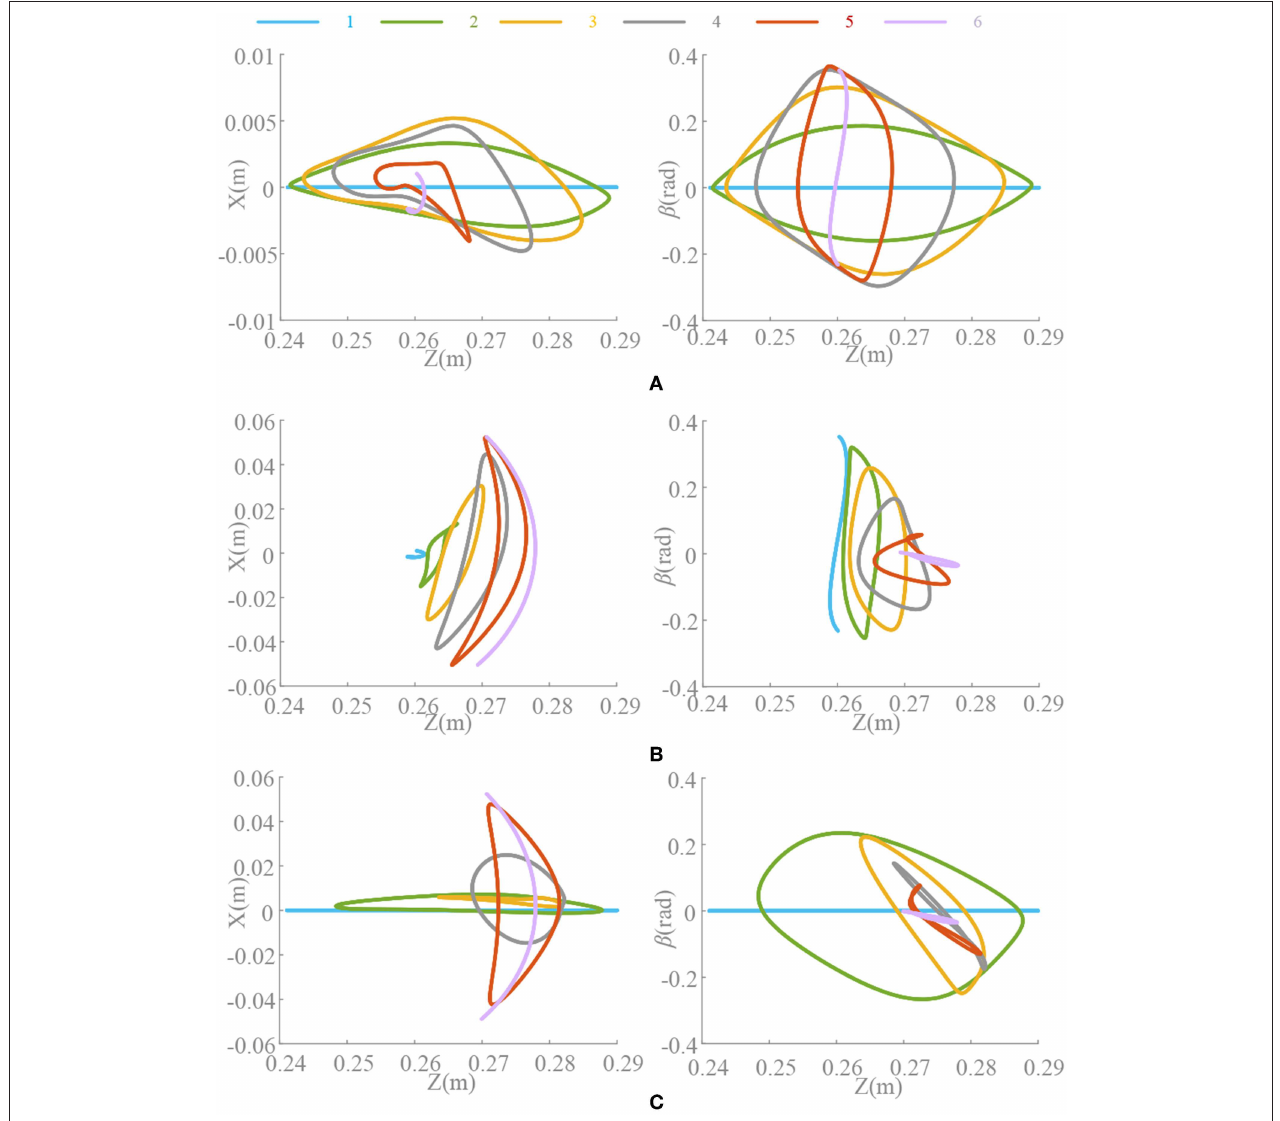
FIGURE 8 | Transformation of different motion patterns. β is the pitch angle round Y. (A) Motion pattern A → motion pattern C. (B) Motion pattern C → motion pattern B. (C) Motion pattern A → motion pattern B. All transformation is conducted in 5 steps. Both phase and amplitude changes